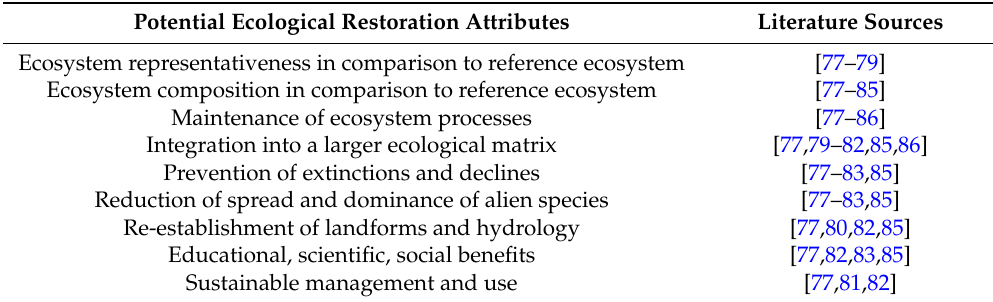
Table 1. Broad attributes of ecological restoration success or progress.